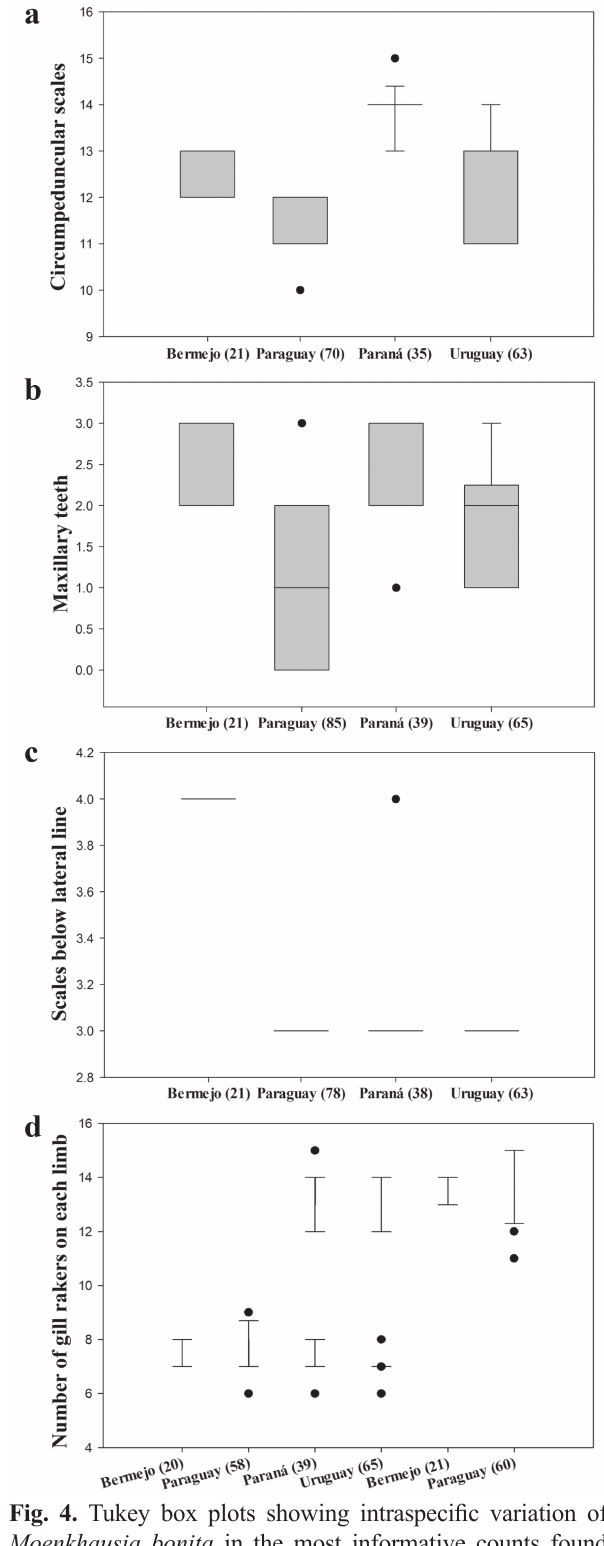
Fig. 4. Tukey box plots showing intraspecific variation of Moenkhausia bonita in the most informative counts found through the multivariate analyses. a. circumpeduncular scales; b. maxillary teeth; c. scales below the lateral line; d. number of gill rakers on each limb (upper vs. lower, in the bottom and top parts, respectively). Number of specimens in